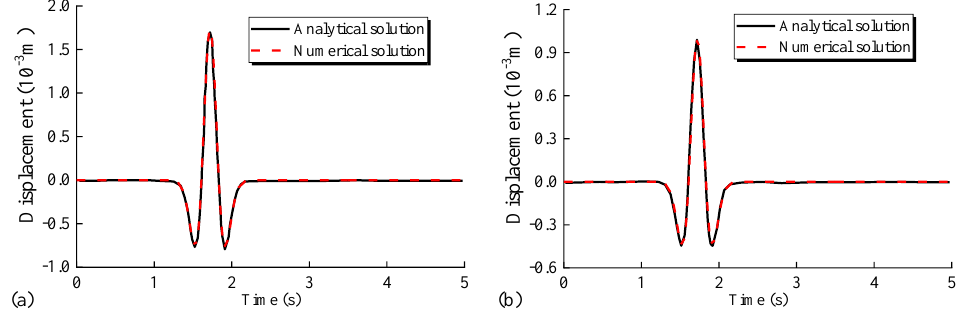
Figure 4. Displacement − time curve of point A when P wave is incident at an angle of 60 ◦ . ( a ) Hori- zontal displacement and ( b ) vertical displacement.